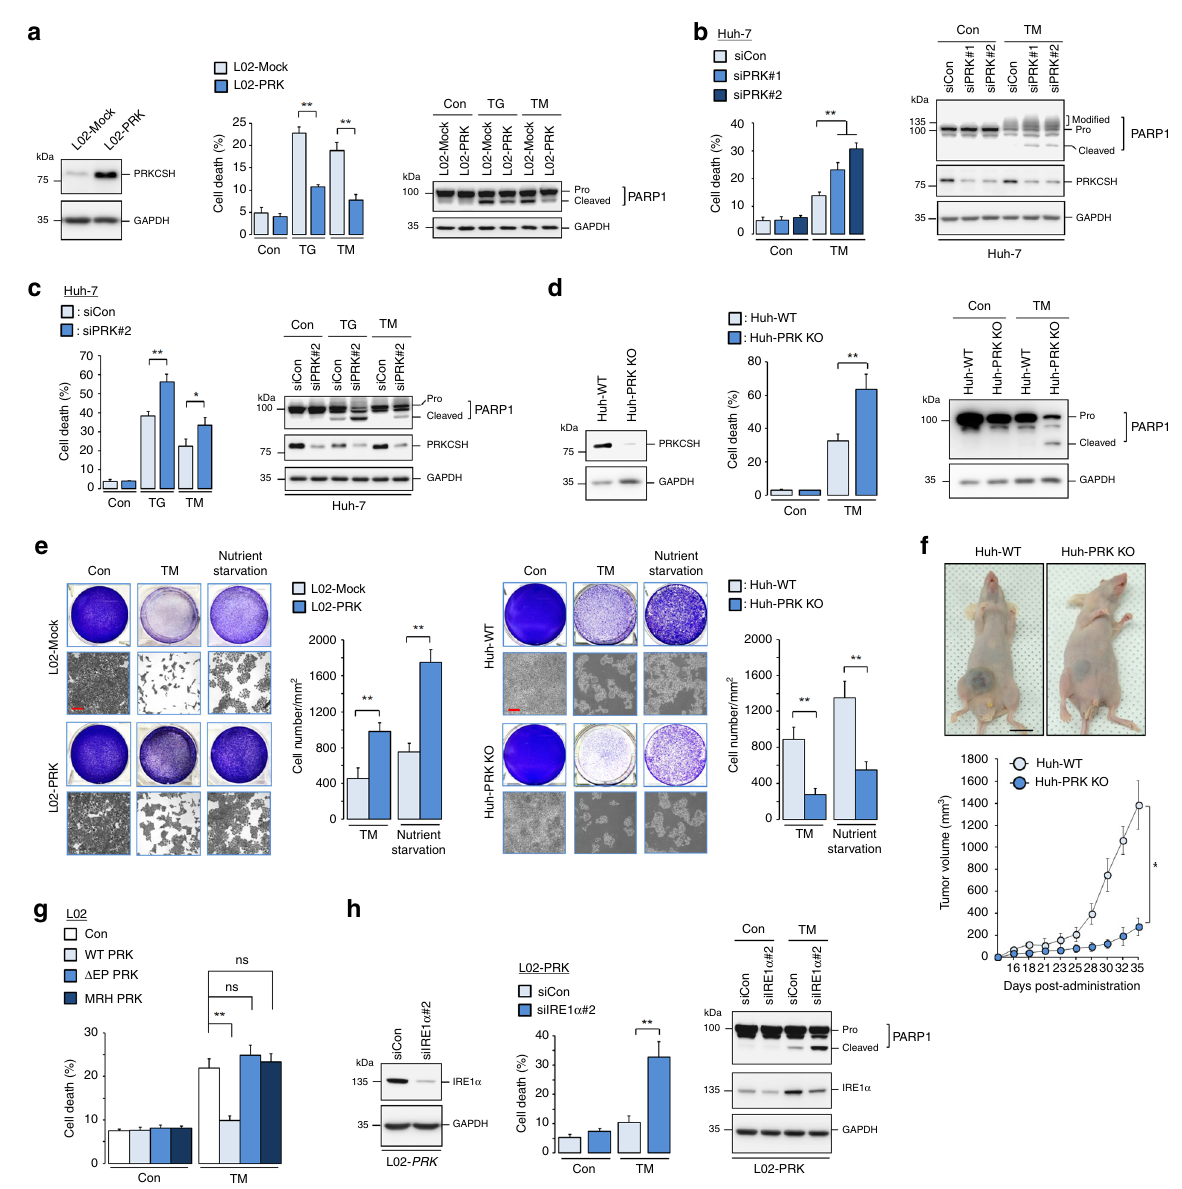
Fig. 7 PRKCSH mitigates ER stress-induced cell death. a Cell death analysis (left) in L02-Mock and L02-PRK cells treated with 10 μ g/mL TM or 1 μ M TG for 72 h. Cell death was determined from PI staining followed by FACS analysis. Immunoblot analysis of PARP1 cleavage (right) in these cells. b Cell death analysis (left) in PRKCSH-silenced Huh-7 cells treated with 10 μ g/mL TM for 48 h. Immunoblot analysis of PARP1 cleavage (right) in these cells. c Cell death analysis (left) in PRKCSH - silenced Huh-7 cells treated with 10 μ g/mL TM or 1 μ M TG for 72 h. Immunoblot analysis of PARP1 cleavage (right) in these cells. d Cell death analysis (left) in Huh-WT and Huh-PRK KO cells treated with 10 μ g/mL TM for 72 h. Immunoblot analysis of PARP1 cleavage (right) in these cells. e Cell survival analysis in L02-Mock and L02-PRK cells (left), and Huh-WT and Huh-PRK KO cells (right). Cells were exposed to 10 μ g/mL TM or EBSS (for nutrient starvation) for 48 h, and then replated in normal cell culture medium. After 5 days, cell viability was determined by staining with crystal violet. Number of cells per area (mm 2 ) was calculated. Scale bars represent 100 µ m. f In vivo tumor growth analysis in xenograft nude mice injected with Huh-PRK KO or WT cells. Balb/c nude mice were subcutaneous transplantated with each tumor cells in the right groin (four mice in each group). The volume of tumors was monitored for 35 days. Representative images of tumor-bearing mice (top) and tumor volumes (bottom) were presented. Scale bars represent 10 mm. g Cell death analysis in L02 cells transfected with the control, WT PRKCSH, Δ E/P, or MRH mutant plasmids; cells were treated with 10 μ g/mL TM for 72 h. h Cell death analysis (left) in IRE1 α -silenced L02-PRK cells treated with 10 μ g/mL TM for 72 h. Immunoblot analysis of PARP1 cleavage (right) in these cells. In cell death analysis and cell survival analysis, data are shown as mean ± SEM from three or four independent experiments. One-way ANOVA; * P < 0.05, ** P <